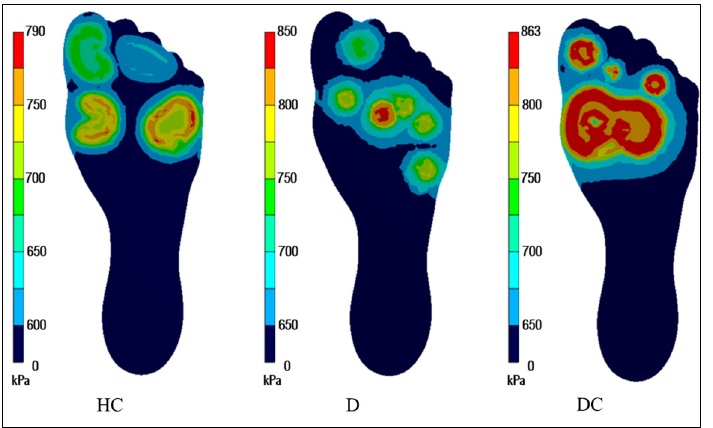
Figure 12. Plantar pressure distribution across the HC, D, and DC group during toe-off phase. Table 2. Peak plantar pressures (kPa) across the HC, D, and DC groups during different gait phases. Gait